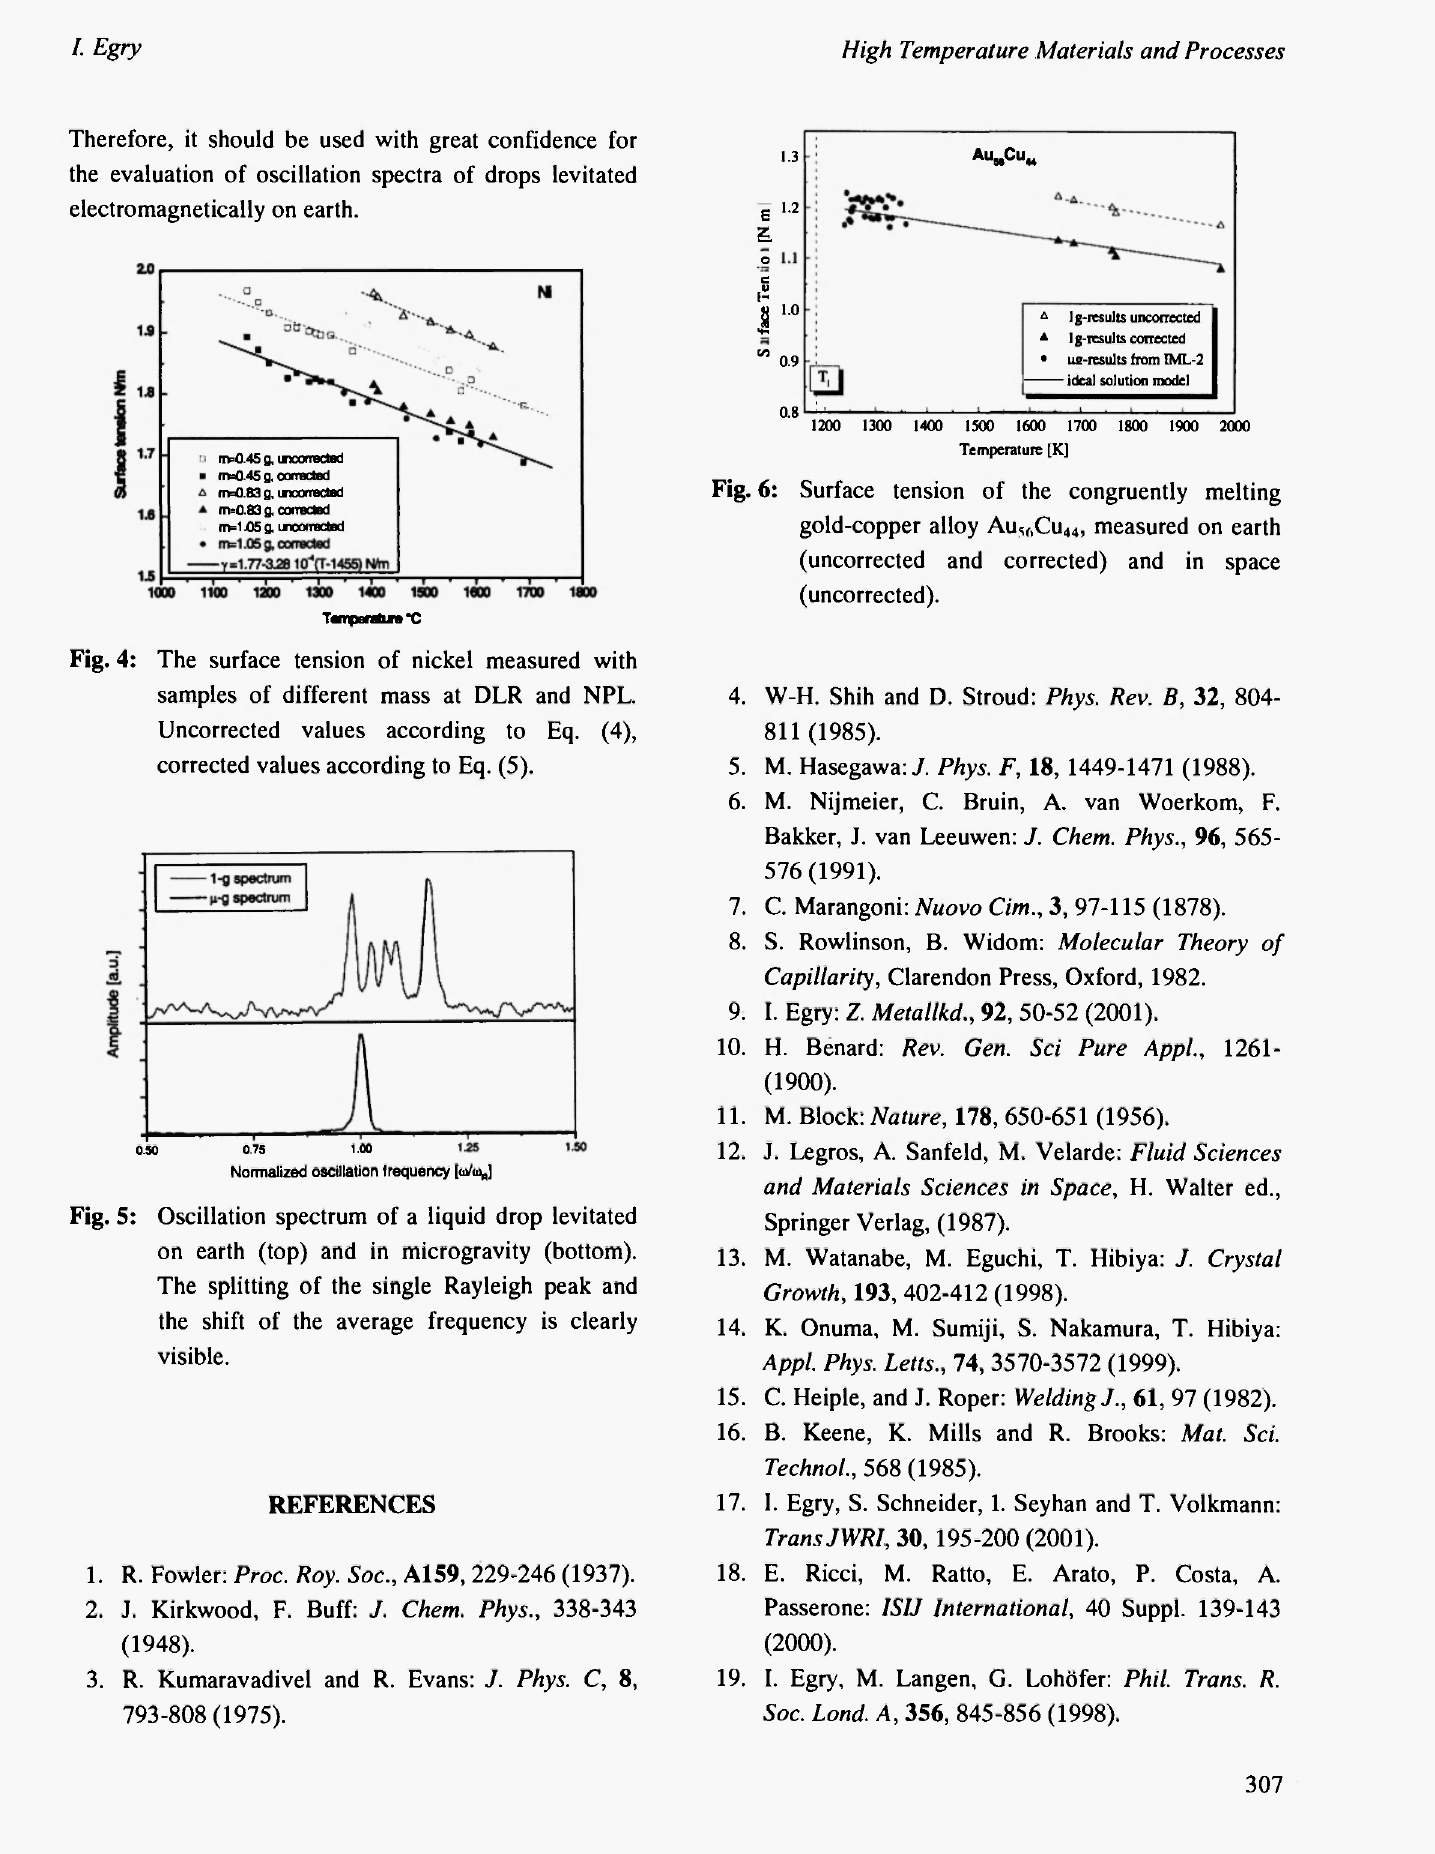
Fig. 5: Oscillation spectrum of a liquid drop levitated on earth (top) and in microgravity (bottom). the shift of the average frequency is clearly visible.